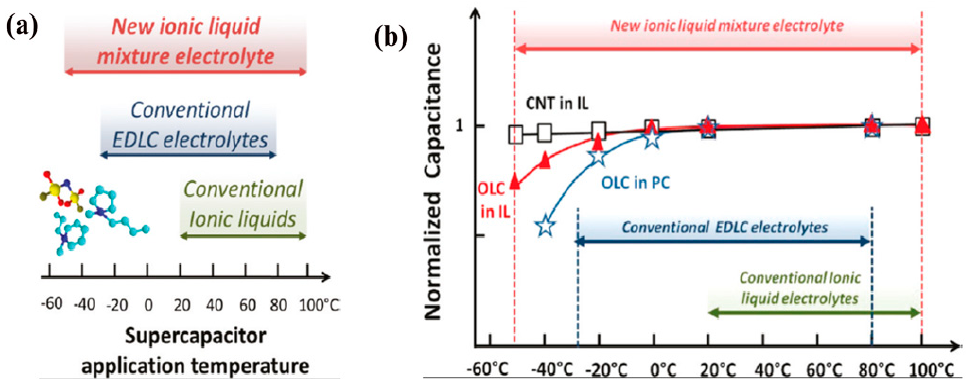
Figure 9. ( a , b ) Change of capacitance (C/C20 °C) versus temperature for the OLC and VA-CNT electrodes in (PIP 13 FSI) 0.5 (PYR 14 FSI) 0.5 IL mixture and PC + 1 M TEA-BF 4 electrolytes. Capacitances were calculated at 100 mV/s, except for the − 50 °C (1 mV/s) and − 40 °C (5 mV/s) experiments. This plot ( b ) shows that the use of the IL mixture extends the temperature range for SCs into the − 50 °C to 100 °C range while conventional electrolytes using PC as the solvent are limited to the − 30 °C to 80 °C range. C 20 °C was 80 mF and 4 mF, respectively, for OLC and VA-CNT cells. The potential window was 0 to 2.8 V, copyright; Reprinted with permission from Ref. [130]. Copyright 2011 American Chemical Society.